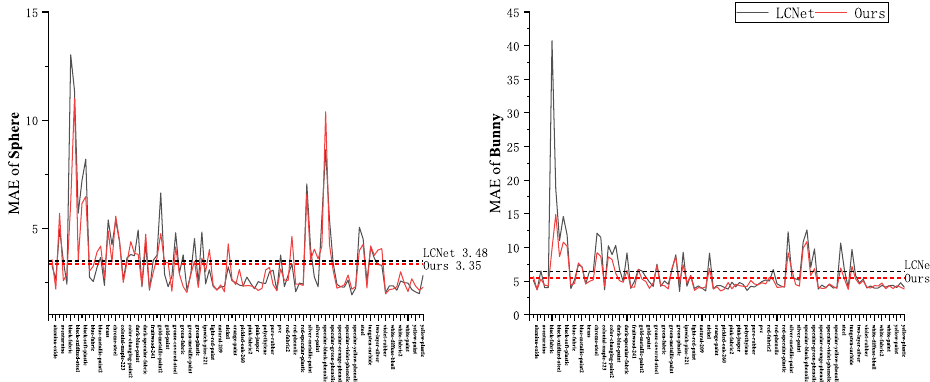
Figure 6. Quantitative comparison of LCNet and our ReDDLE-Net for the Bunny and Dragon objects made of 100 MERL materials. The horizontal axis represents the names of the materials and the vertical axis represents the MAE. The horizontal coordinate represents the names of the materials in the 100 MERL dataset. The dashed line is the average error reference line for each